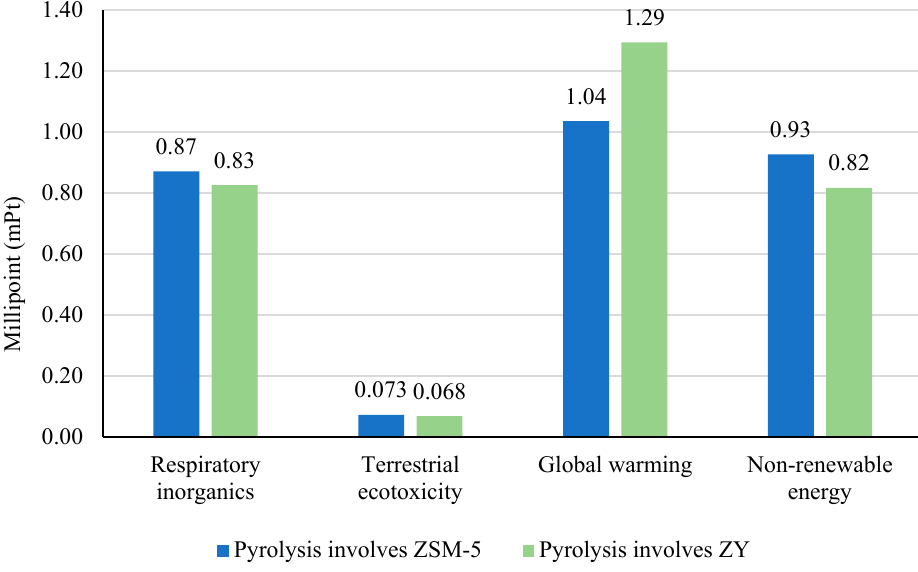
Figure 3. Single score LCA results for two different catalytic pyrolysis Figure 3.Single score LCA results for two different catalytic pyrolysis processes